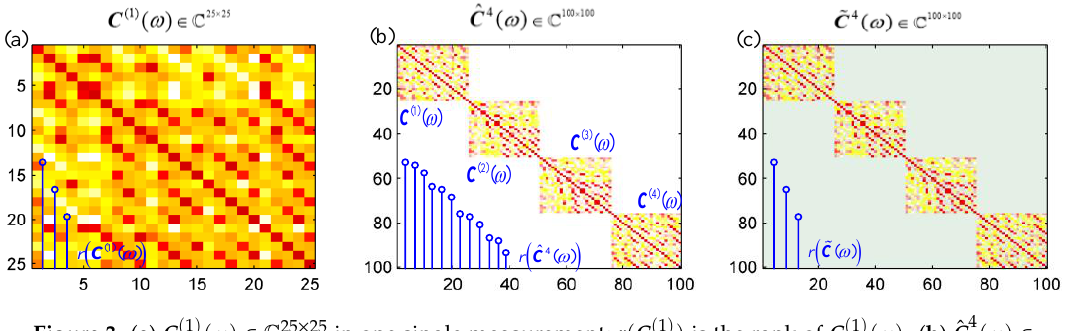
Figure 3. ( a ) C ( 1 ) ( ω ) ∈ C 25 × 25 in one single measurement; r ( C ( 1 ) ) is the rank of C ( 1 ) ( ω ) . ( b ) ˆ C C 100 × 100 by arranging C ( i ) ( ω ) , i = 1,2,3,4 in the diagonal block position; r ( ˆ C 4 ) is the rank of ˆ C 4 ( ω ) . 4 ( ω ) ∈ C 100 × 100 with the non-synchronous measurements by implementing the missing data at the ( c ) (cid:101) C 4 4 ) is the rank of (cid:101) C ( ω ) non-diagonal block; r ( (cid:101) C